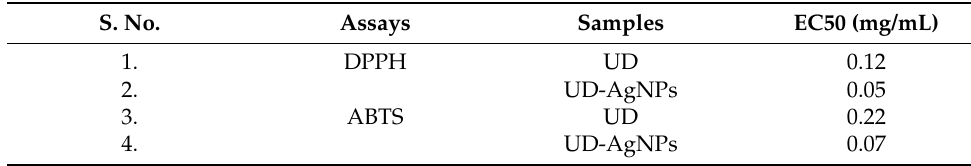
Table 2. Using DPPH and ABTS assays, various models were used to estimate the predicted EC 50 (mg/mL) of UD and UD-AgNPs.